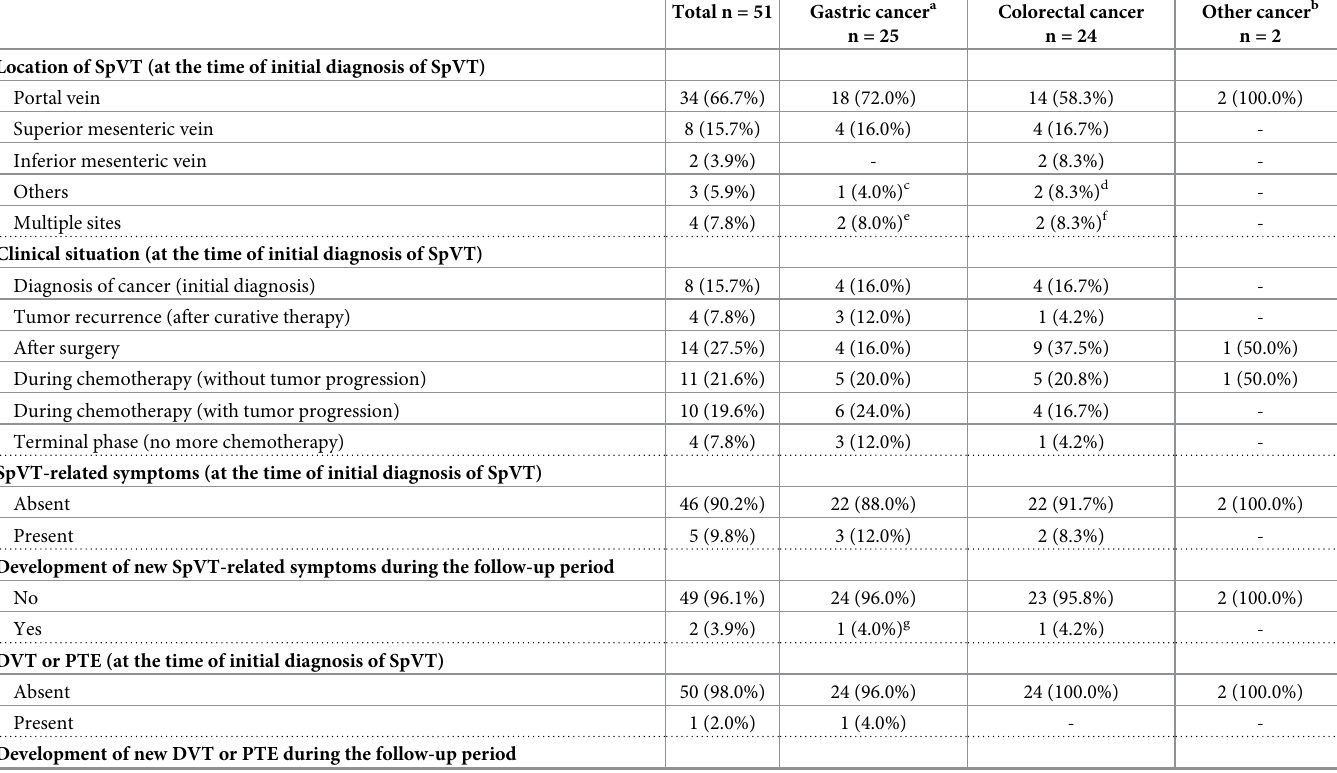
Table 2. Clinical characteristics of splanchnic venous thrombosis